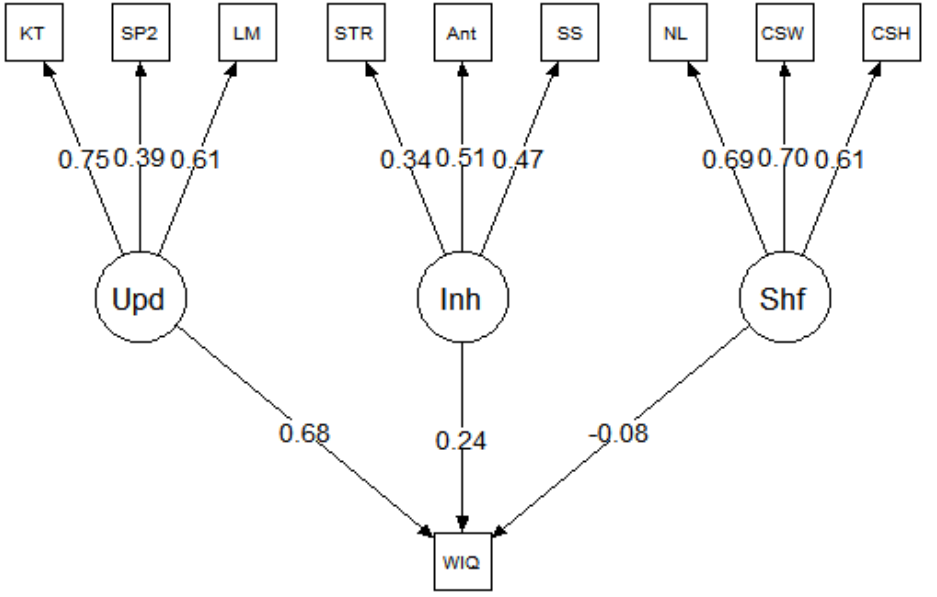
Figure 6. Reanalysis of Friedman et al. (2006). Inh = inhibition; Upd = updating; Shf = shifting; WAI = WAIS IQ; Rvn = Raven’s matrices; BDW = block design WAIS.